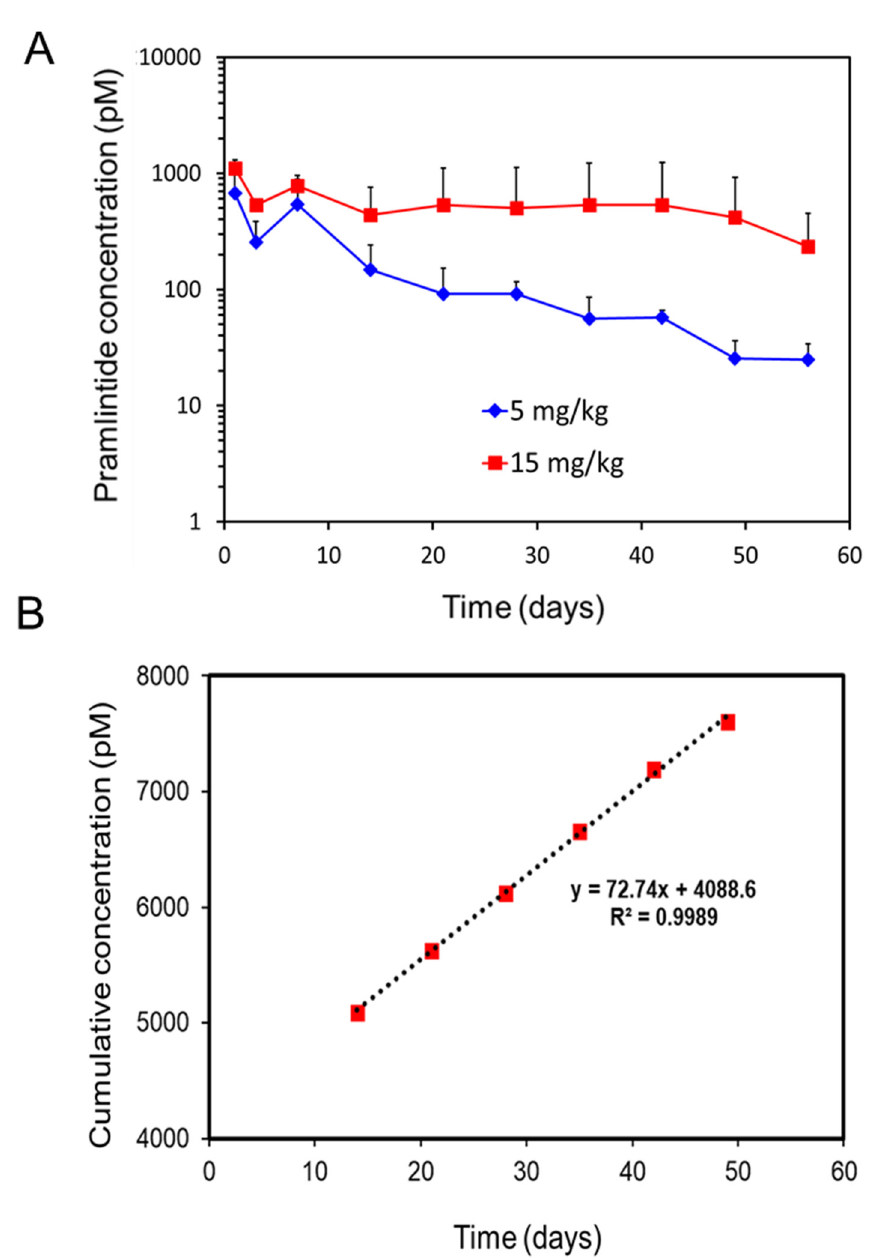
Figure 5. ( A ) Pramlintide plasma concentration in the rat after subcutaneous injection of pramlintide- silica depot at two doses (containing 5 mg/kg and 15 mg/kg pramlintide). Mean and SD, n = 5 rats. ( B ) Cumulative concentration vs. time plot depicting the zero-order release of pramlintide from silica depot at higher dosing (15 mg/kg) from 14 to 49